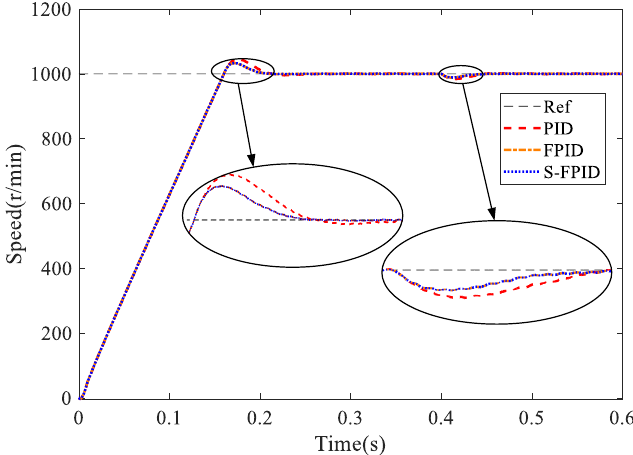
Figure 9. Simulation results of step response with disturbance.